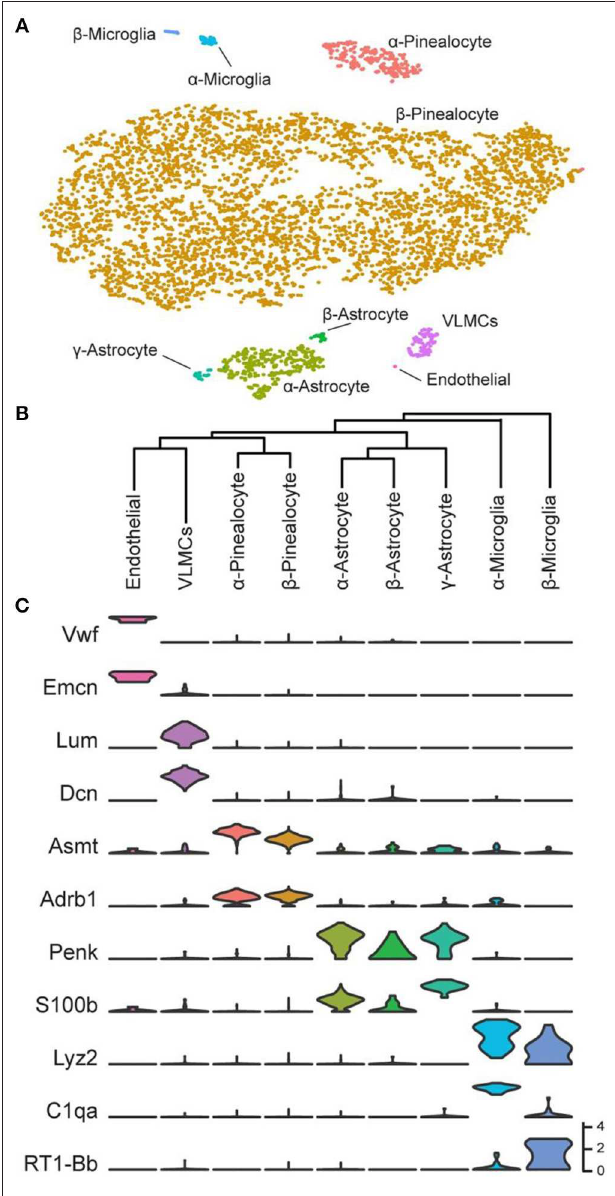
FIGURE 3 | IHC reveals cell type-specific patterns of expression. IHC sections through the rat pineal gland midline; rostral stalk origin at the bottom. The length and middle third of the width of the gland appear. Scale bar = 100 µ m. (A) Uniform distribution of ASMT-positive pinealocytes. (B) Slc1a3-positive γ -astrocytes abundance is greatest in rostral/stalk region. (C) S100b-positive cells are abundant in the rostral region; they appear elsewhere with distinctly lower density and weaker expression strength. (D) Aif1-positive cells are unevenly distributed throughout pineal gland at low density. See Figure S6 in Mays et al. (43) for full images and further details. Reproduced from Mays et al. (43). This figure and associated legend is published with permission of